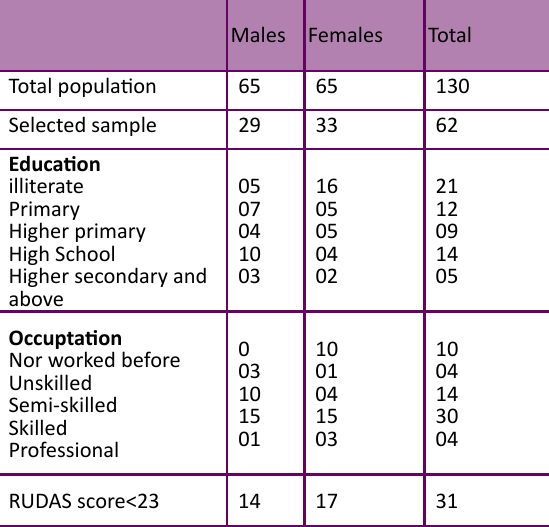
Table 1 – Socio-demographic data and the RUDAS score of the institutionalized elderly individuals Males Females